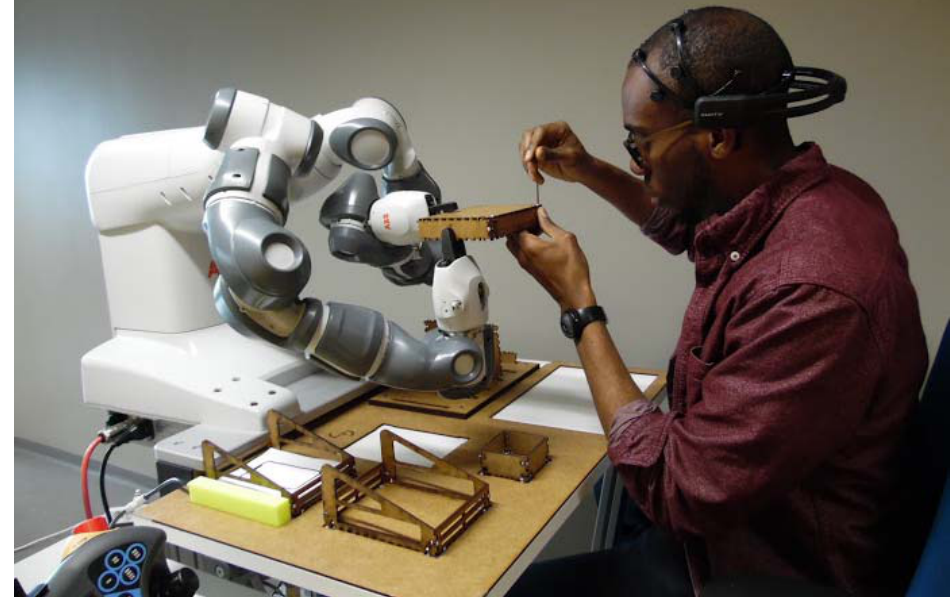
Figure 6. Layout of the workstation for the assembly process.